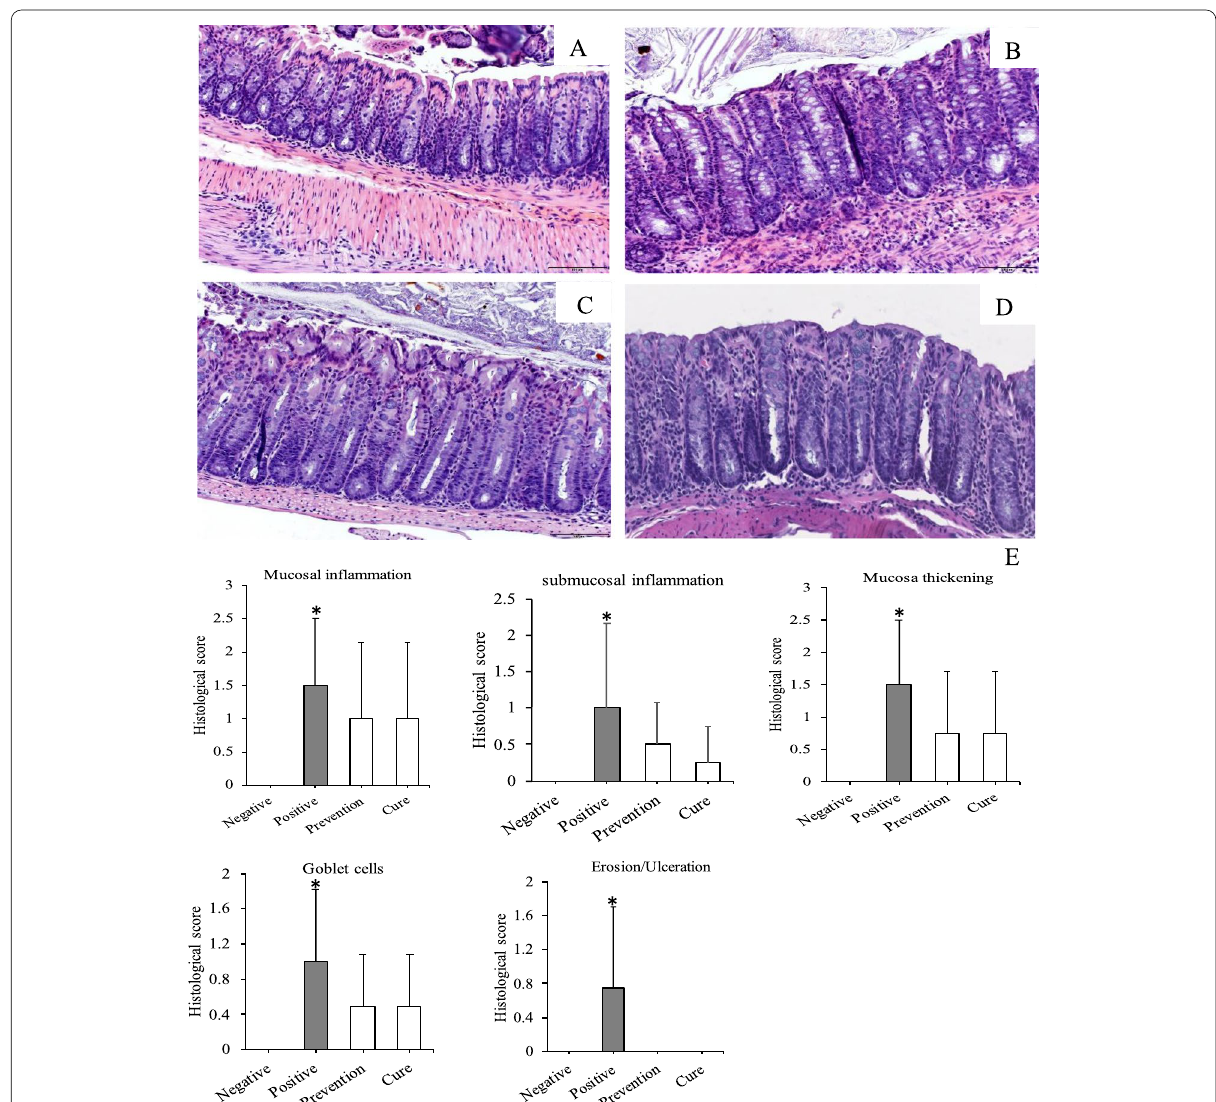
hyperplastic mucosal epithelium with superficial sloughing of cells accompanied by inflammation in the mucosal and submucosa. C Citrobacter rodentium -infected mouse in the prevention group, with immobilized Lactobacillus plantarum initiated 3-days before infection. Mucosal hyperplasia and inflammation are mild. D Citrobacter rodentium -infected mouse in the cure group, with immobilized L. plantarum initiated 3-days after infection. Mucosal hyperplasia and inflammation are mild. (Scale bars 100 μm). E Blinded histological scores showing significant differences between C. = rodentium and L. plantarum treated mice (* p <